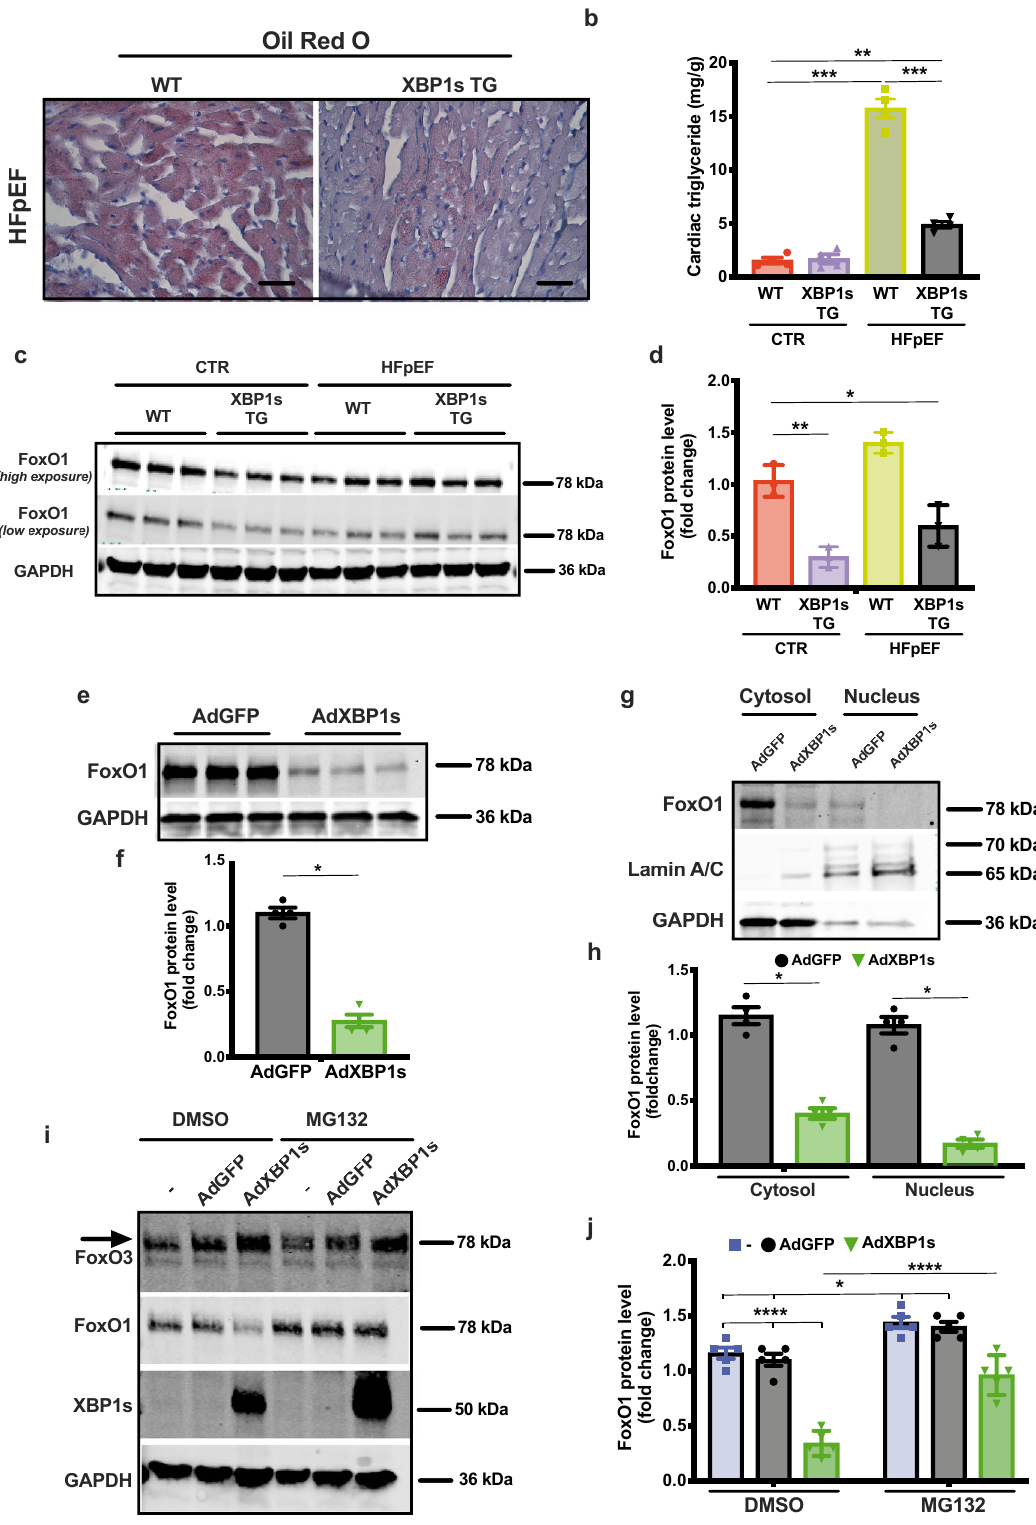
FoxO1 promotes lipid accumulation in HFpEF cardiomyo- cytes . Our preclinical two-hit model of HFpEF stems from the combination of metabolic alterations (exposure to high-fat diet; HFD) and endothelial dysfunction-driven hypertension (modeled using the inhibitor of constitutive nitric oxide synthases N [w] - nitro-l-arginine methyl ester; L -NAME) to recapitulate